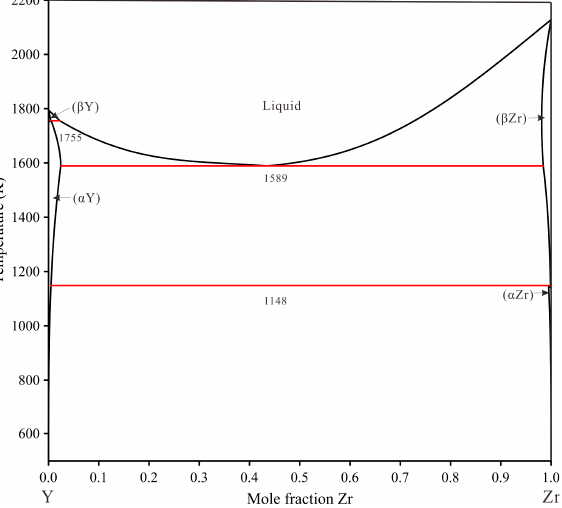
Figure 3. Calculated Y–Zr phase diagram using the parameter from Bu et al. [22].